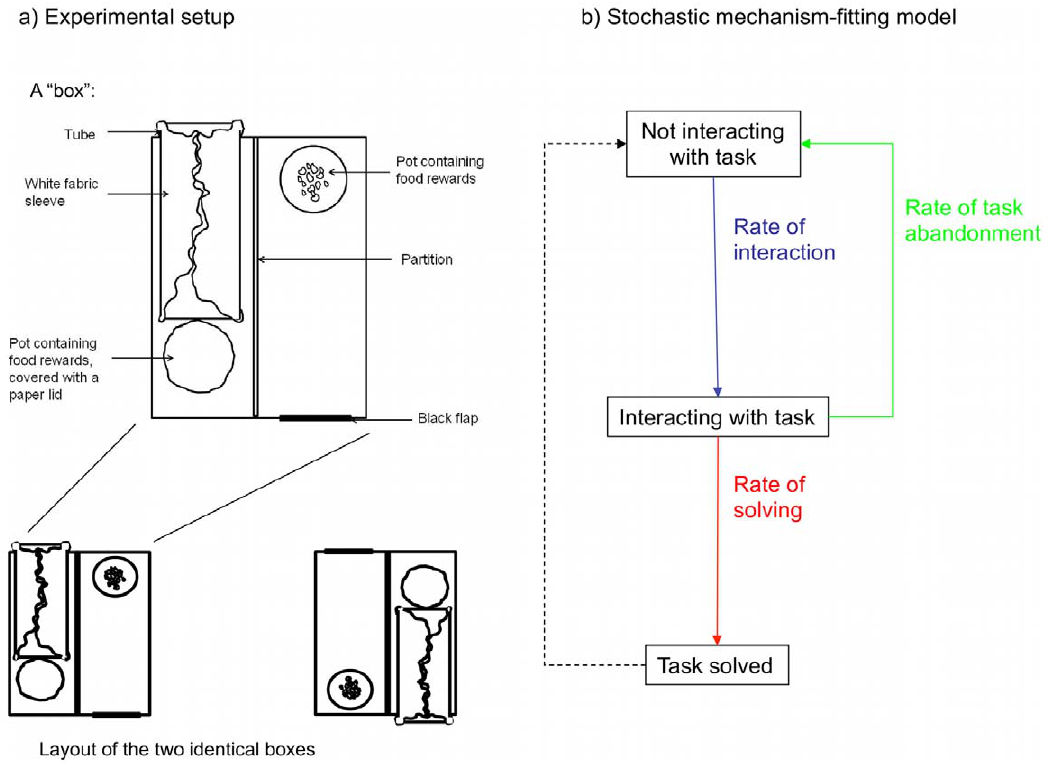
Figure 1. Experimental setup and model structure. A) A ‘‘Box’’. The ‘‘Flap’’ technique involved going through a black cat flap to obtain food from a pot; the ‘‘Tube’’ technique involved pushing through a fabric sleeve on the tube and breaking a paper lid to obtain food; B) experimental layout of the two identical Boxes; C) diagrammatic representation of the stochastic mechanism-fitting model (SMFM) showing the three rates of transition that were modelled. In reality ‘rate of interaction’ involved modelling four ‘competing’ transition rates, to each of the four options available: left Flap, right Flap, left Tube and right Tube. We recorded an individual as solving the task when it gained access to food inside the box, and as abandoning the task when it terminated a bout of interaction without gaining access to food inside the